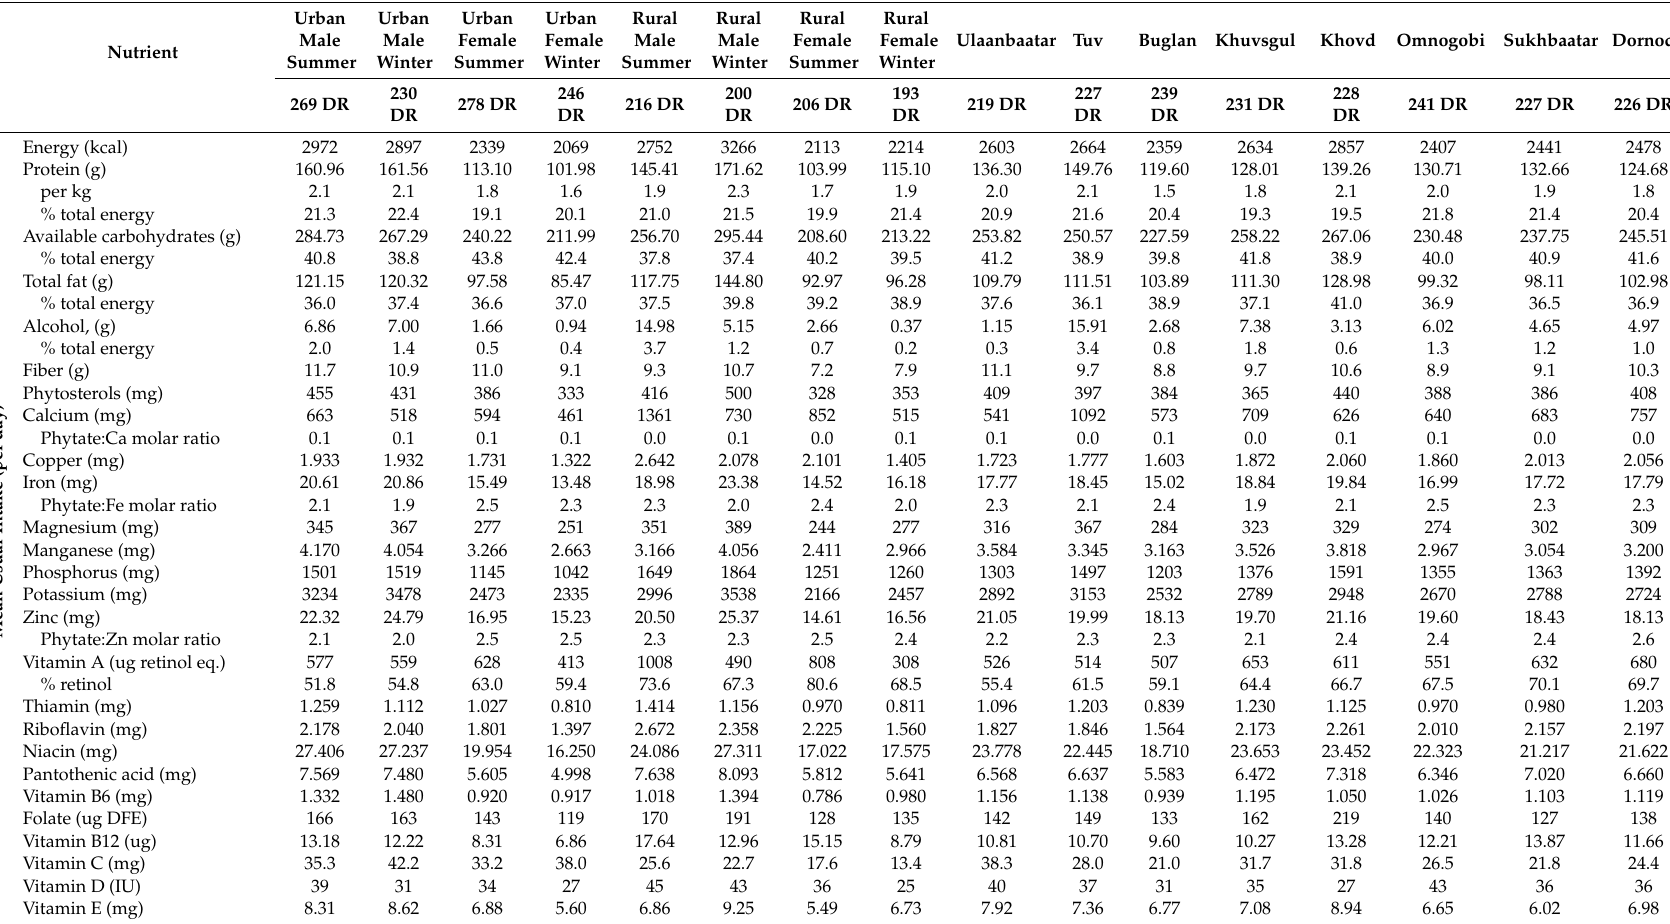
Table 2. Mean usual nutrient intake (per day) and prevalence of nutrient inadequacy (% < estimated average requirement) by subgroup-season and province.